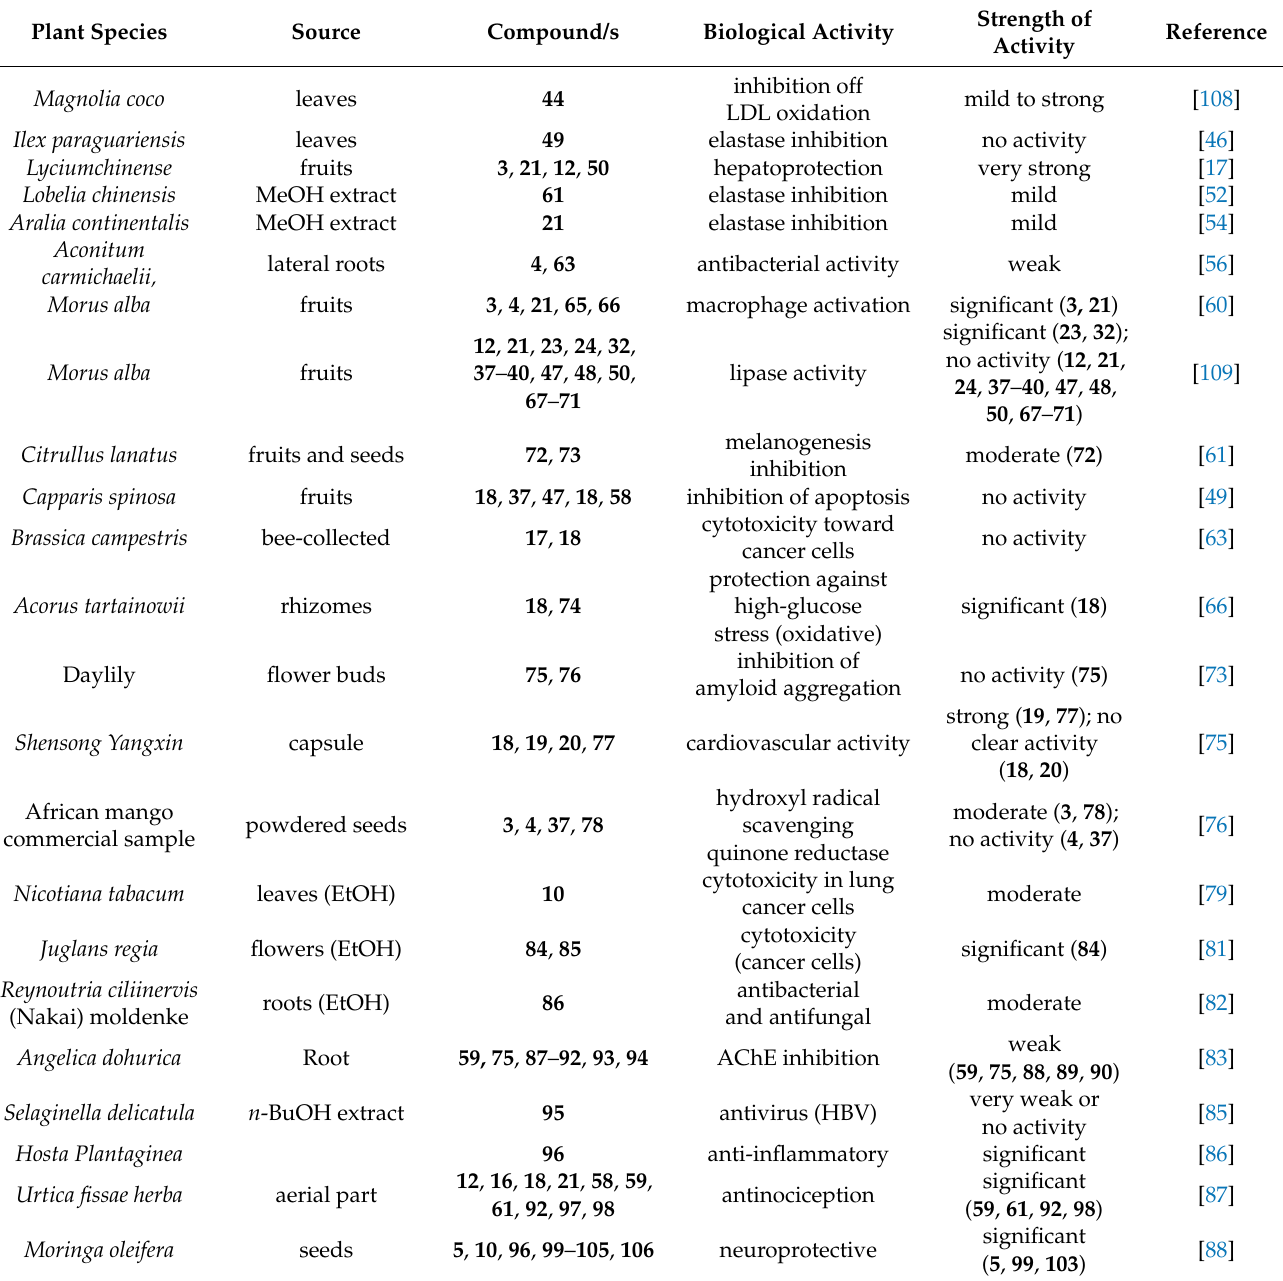
Table 2. Biological activity of compounds isolated from plant